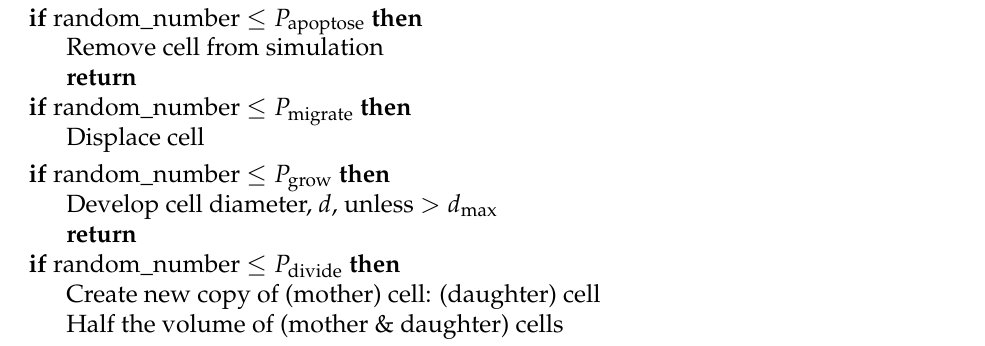
Algorithm 1 Cell behaviour algorithm that is iterated for all cells (agents) and for all time-steps of an ABM